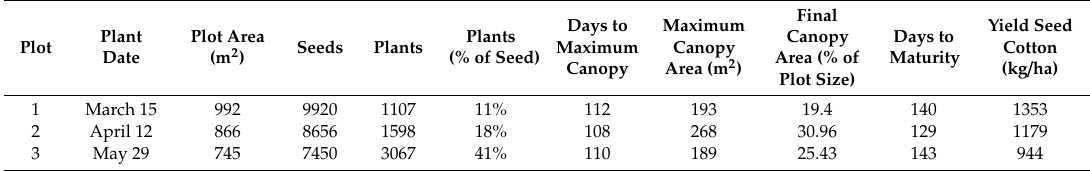
Table 1. Plot-level agronomic data for three plantings.